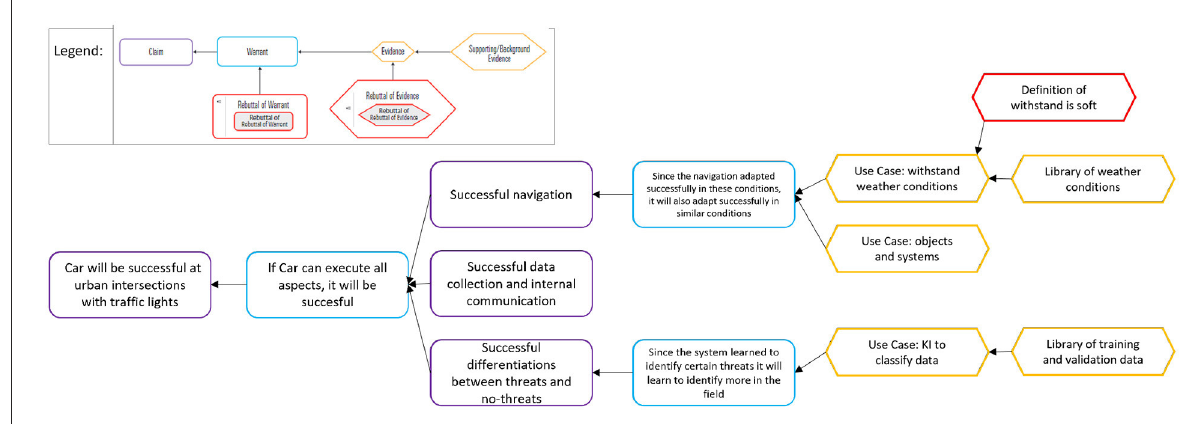
FIGURE7 Example classified according to the Toulmin method—extract (c.f. Toulmin,